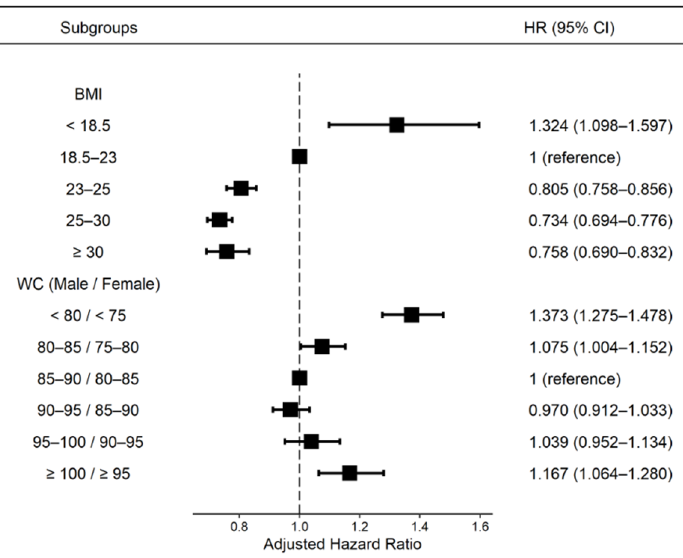
Figure 2. hazard ratios of ESRD according to the baseline BMI and waist circumference. Adjusted for age and sex, smoking, alcohol consumption, regular exercise, low-income status, use of insulin, number of oral hypoglycemic agents, diabetes duration, and previous histories of hypertension and dyslipidemia. BMI, body mass index; WC, waist circumference; HR, hazard ratio; CI, confidential interval.